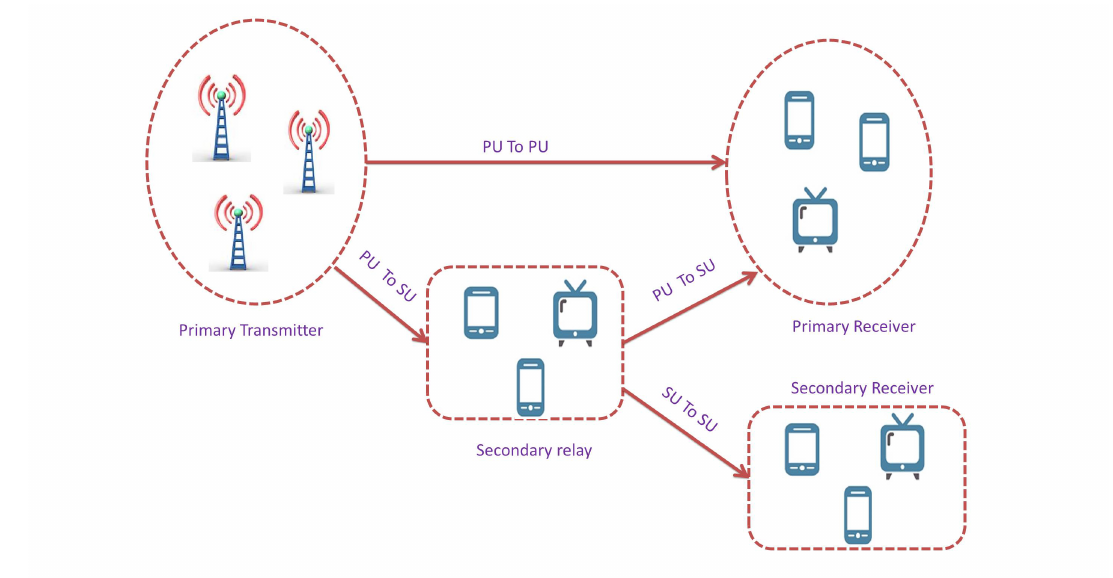
Figure 1. Basic architecture of relaying in cognitive relay networks